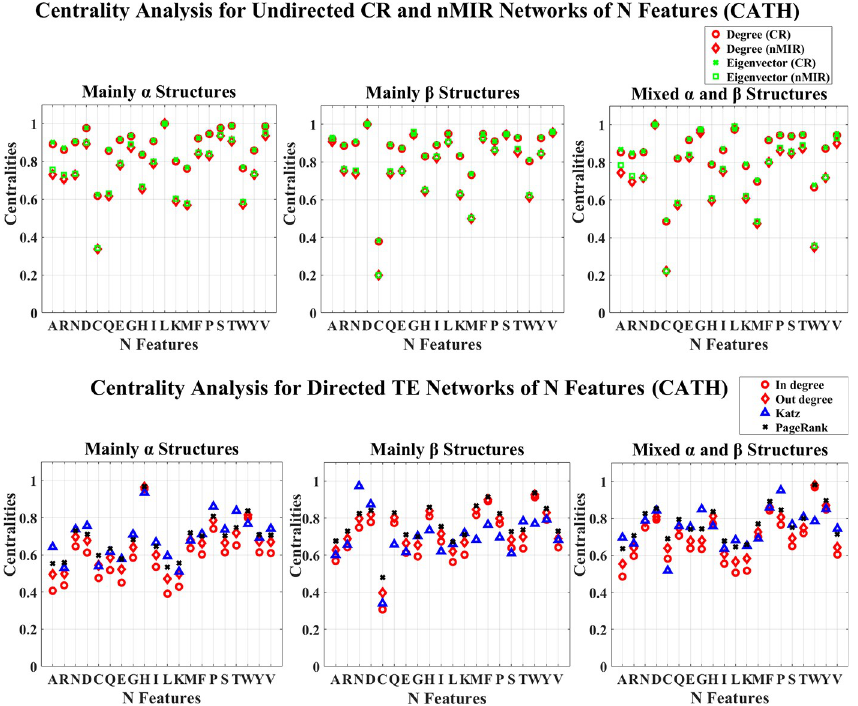
Fig 1. Centrality analysis for the networks of N features (CATH). This figure shows the centrality results for the networks of N features (CATH data). The normalized centralities are plotted against the features (represented by the amino acid abbreviations). In the CR and nMIR networks, the red curves represent the degree centralities, while the green curves represent the eigenvector centralities. In the TE networks, the red curves present the in and out degree centralities, the blue and black curves represent the Katz and PageRank